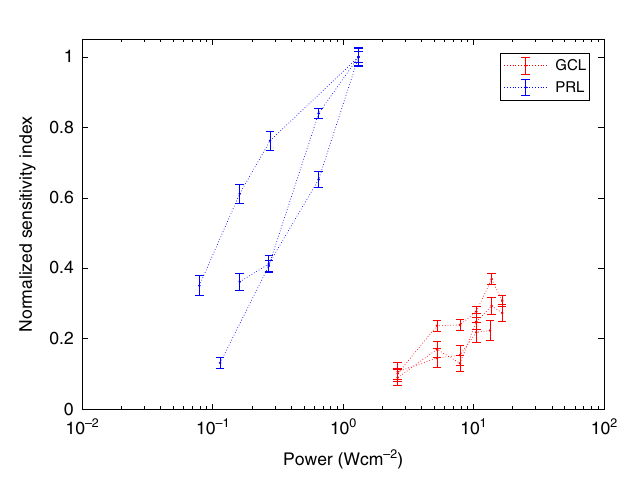
Fig. 3 Comparison of photoreceptor mediated RGC activity (blue) and ChrimsonR mediated RGC activity (red) over a range of stimulus powers. Spatially localized grating stimuli were focussed on the photoreceptor layer (PRL), or directly on the ganglion cell layer (GCL). Mean cellular response was quanti fi ed as the sensitivity index normalized to the maximum photoreceptor response for that ascending staircase. Dashed lines connect data from the same ascending staircase. Two data sets were recorded from 128 cells, 51 weeks after injection, and the third from 90 cells 61 weeks after injection. To achieve the same level of RGC activity in this high light regime, the optogenetic stimulus had to be two orders of magnitude more intense than the photoreceptor stimulus. Data are presented as mean values + / − standard deviation. Source data are provided as a Source Data fi